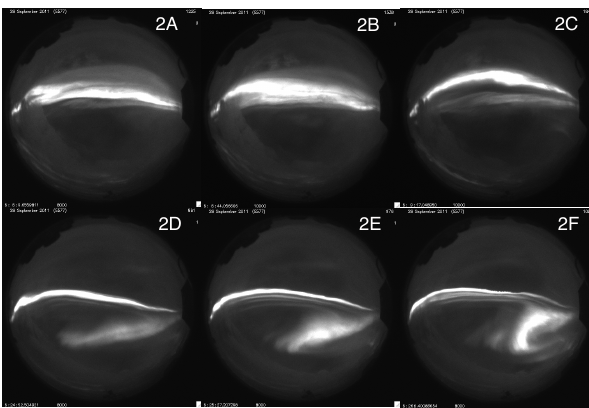
Figure 6. Event 2: all-sky images – taken on 28 September 2011 with a 557.7nm filter – showing the dynamic overall structure of the aurora at the times of the NEIALs in the PFISR data (labeled 2A–2F). In this orientation, north is down and east is to the